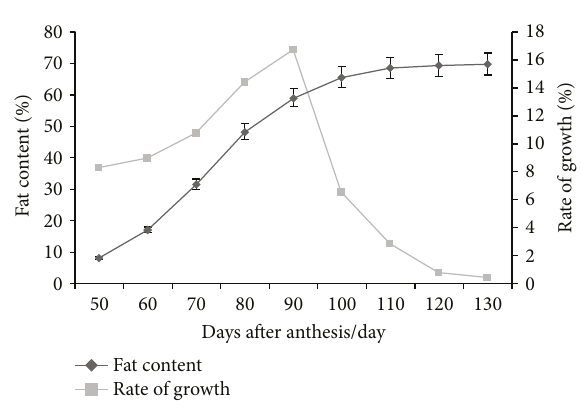
Figure 1: Dynamic changes of fat content in walnut